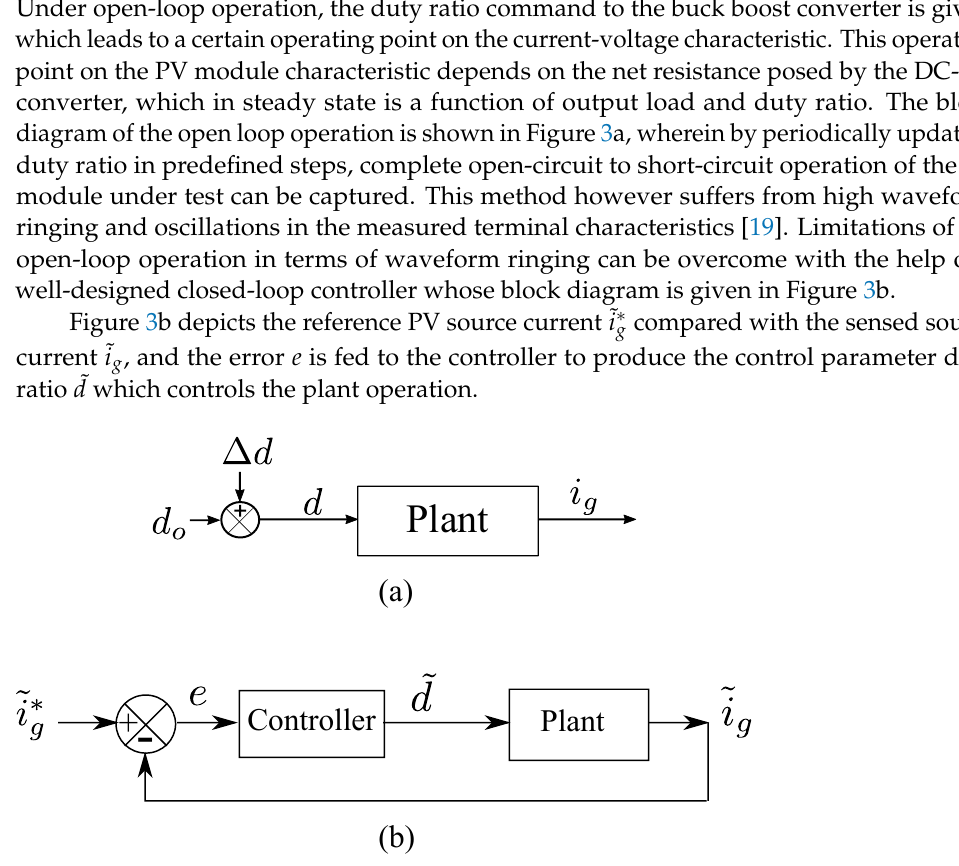
Figure 3. ( a ) Open-loop block diagram of the PV characterization setup. ( b ) Closed-loop block diagram of the PV characterization